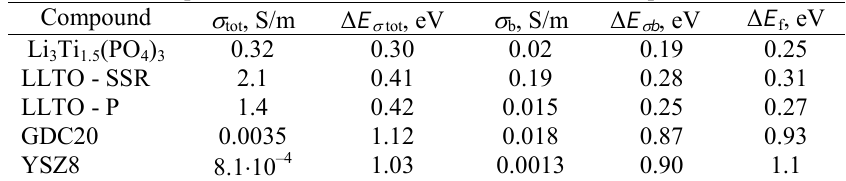
Table 2:  tot ,  b , their activation energies and the activation energy of the relaxation frequency in bulk of Li 3 Ti 1.5 (PO 4 ) 3 , LLTO ceramic samples at 400 K and GDC20, YSZ8 ceramic samples at 600